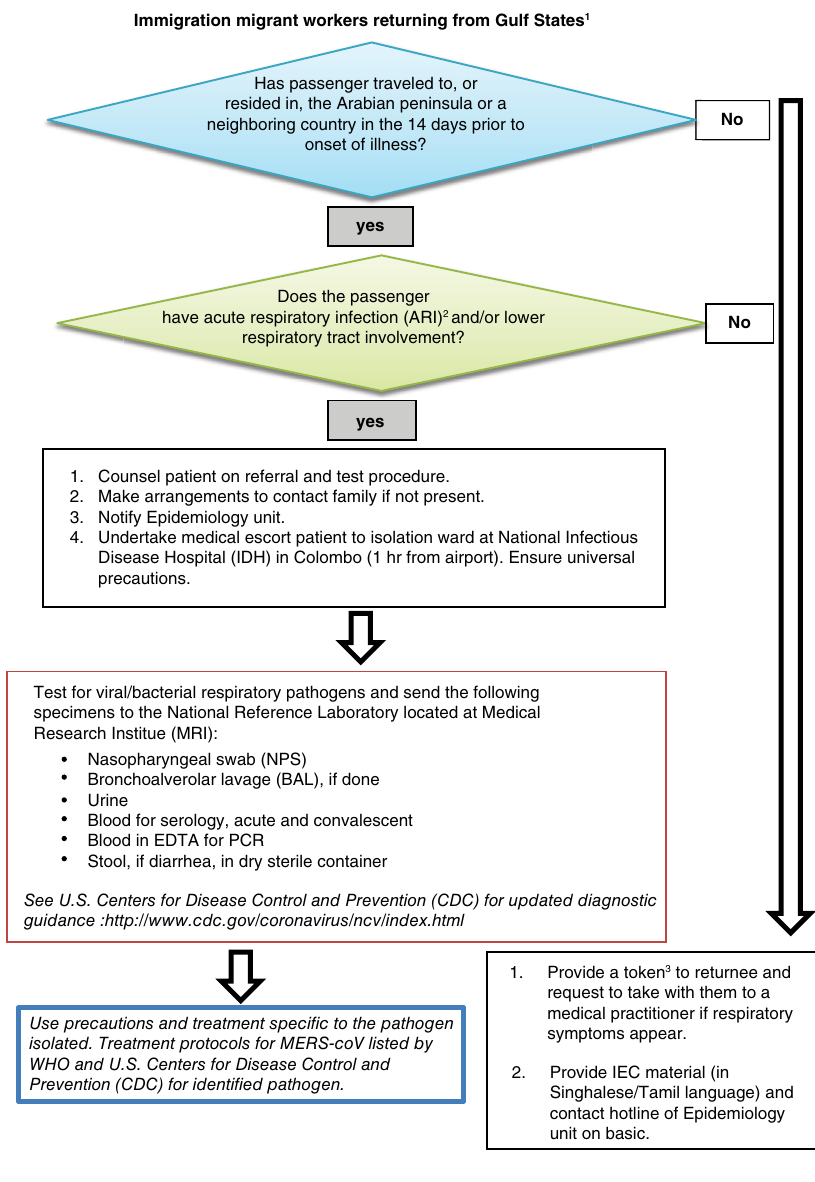
Figure 3. Potential screening algorithm for Middle East respiratory syndrome (MERS-CoV) at Bandaranaike International airport. 1 Immigration Counter Referral for those migrant workers returning from Arabian peninsula and neighboring Middle East countries (Saudi Arabia, Qatar, Jordan, United Arab Emirates, Bahrain, Iran, Iraq, Israel, Kuwait, Lebanon, Oman, Palestinian Territories, Yemen, Syria). Referral to Airport health unit may also be directed from the SLFBE migrant worker arrival desk. 2 Acute Respiratory Infection (ARI): Any new onset acute respiratory infection that could potentially be spread by the droplet route (either upper or lower respiratory tract), which presents with symptoms of a new or worsening cough or shortness of breath and often fever (>38°Celsius). 3 This token will identify the migrant worker as a susceptible person for